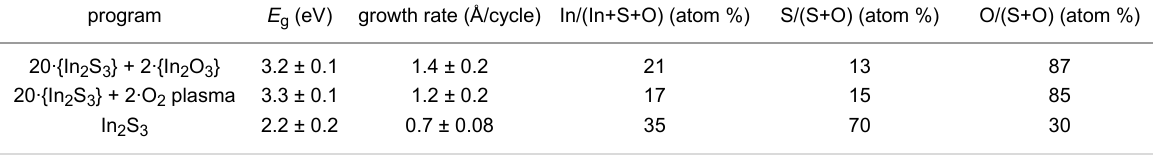
Table 3: Comparison between In 2 (S,O) 3 films, synthesized with and without In(acac) 3 during the oxidation pulse, and In 2 S 3 . program E g (eV)